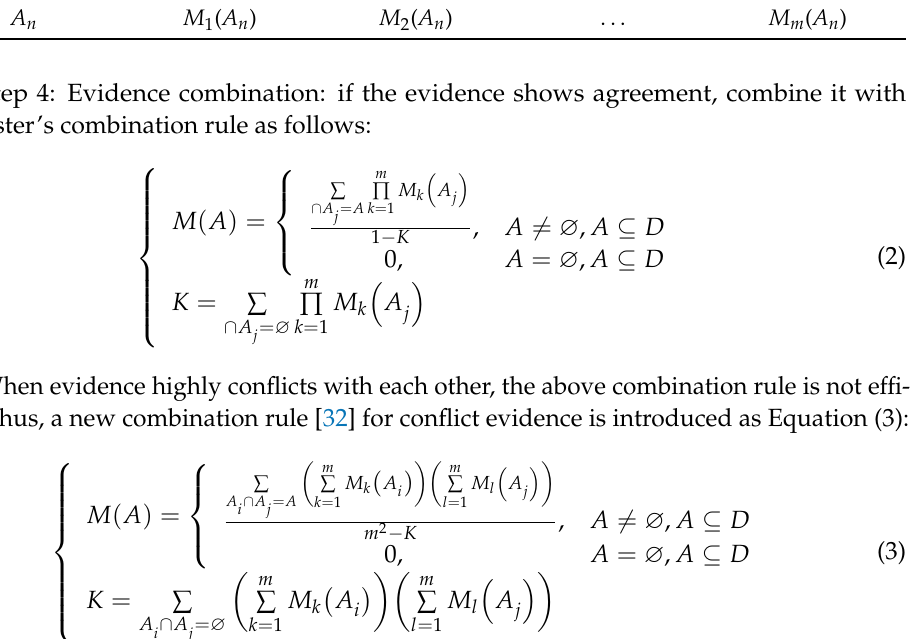
Table 1. The BPA value assigned by experts. Focal Element Expert E 1 Expert E 2 . . . Expert E m A